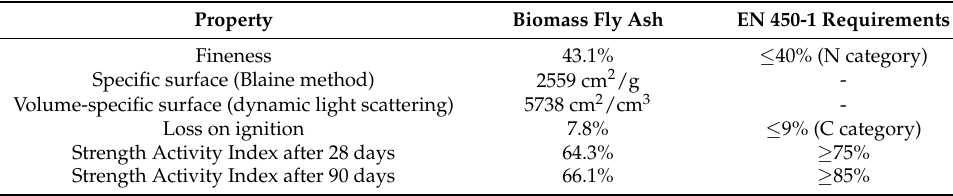
Table 2. Physical properties of biomass fly ash used in the study before activation.